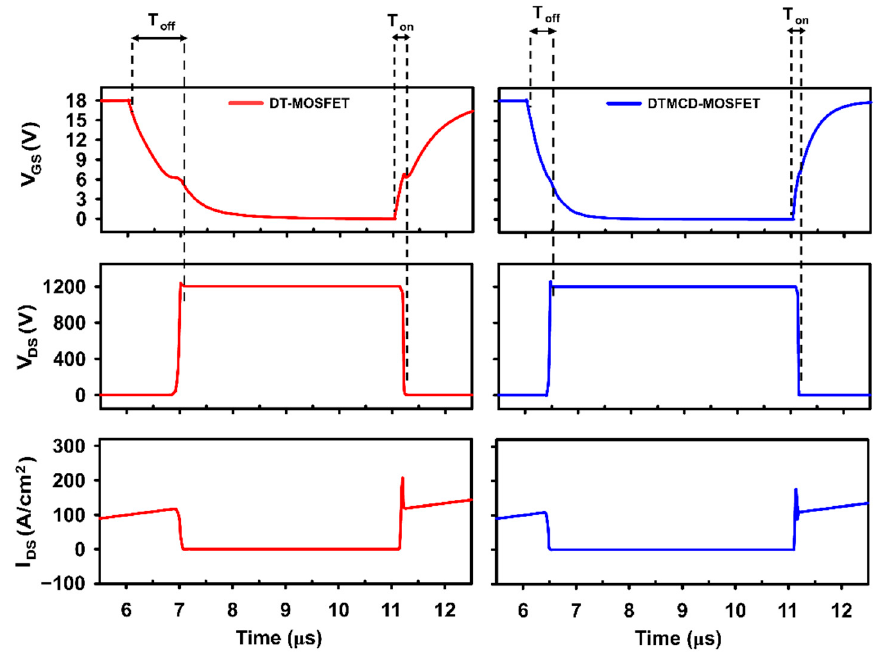
Figure 12. Switching waveforms of DT-MOSFET and DTMCD-MOSFET.